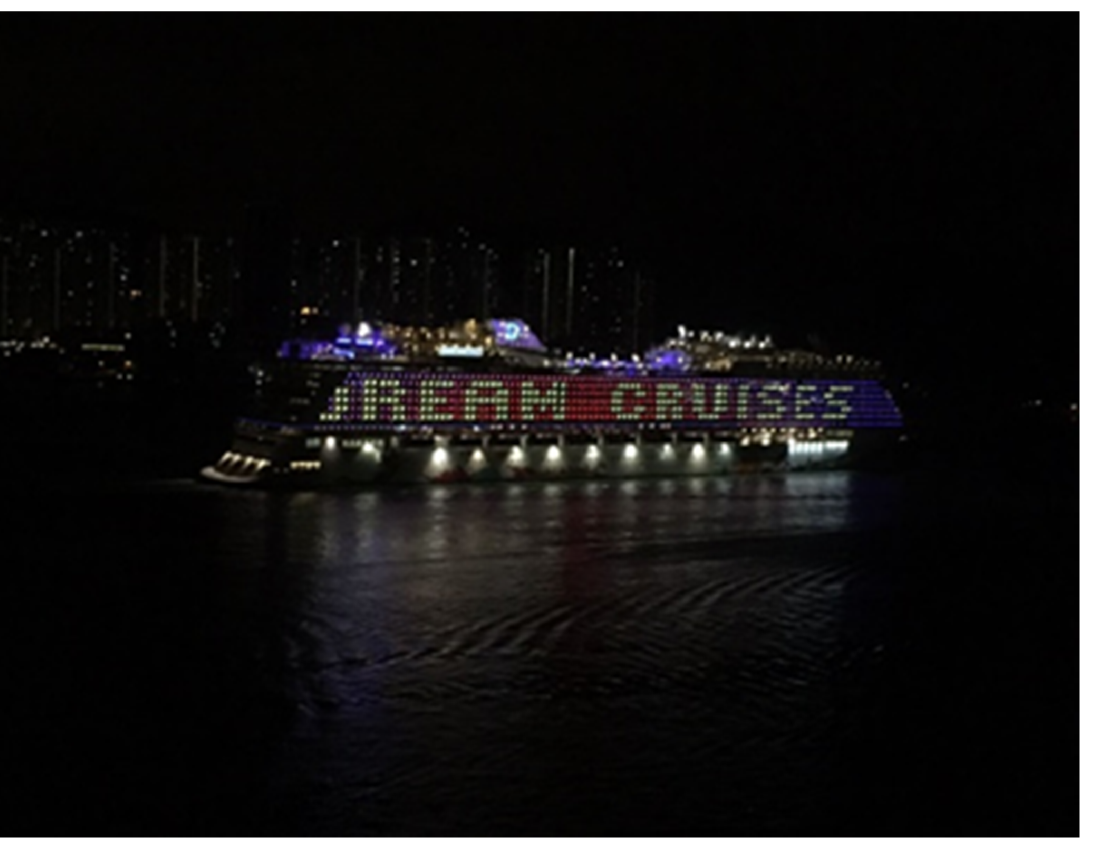
Figure 3. Photograph by Participant E.